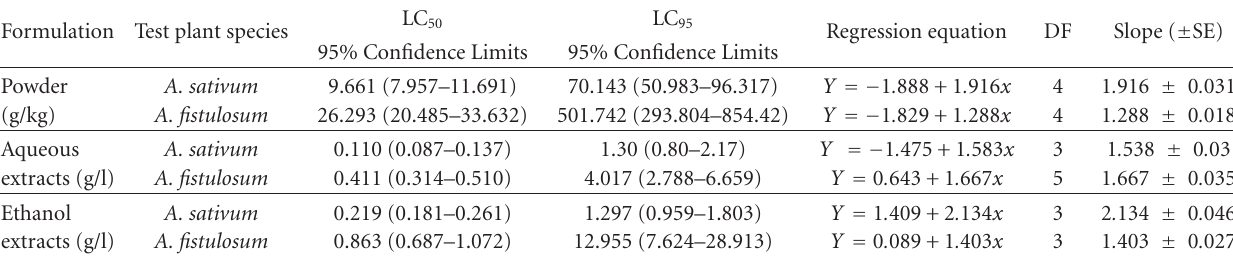
Table 1: Acute (48h) toxicity of test plant materials against Callosobruchus maculatus. Formulation Test plant